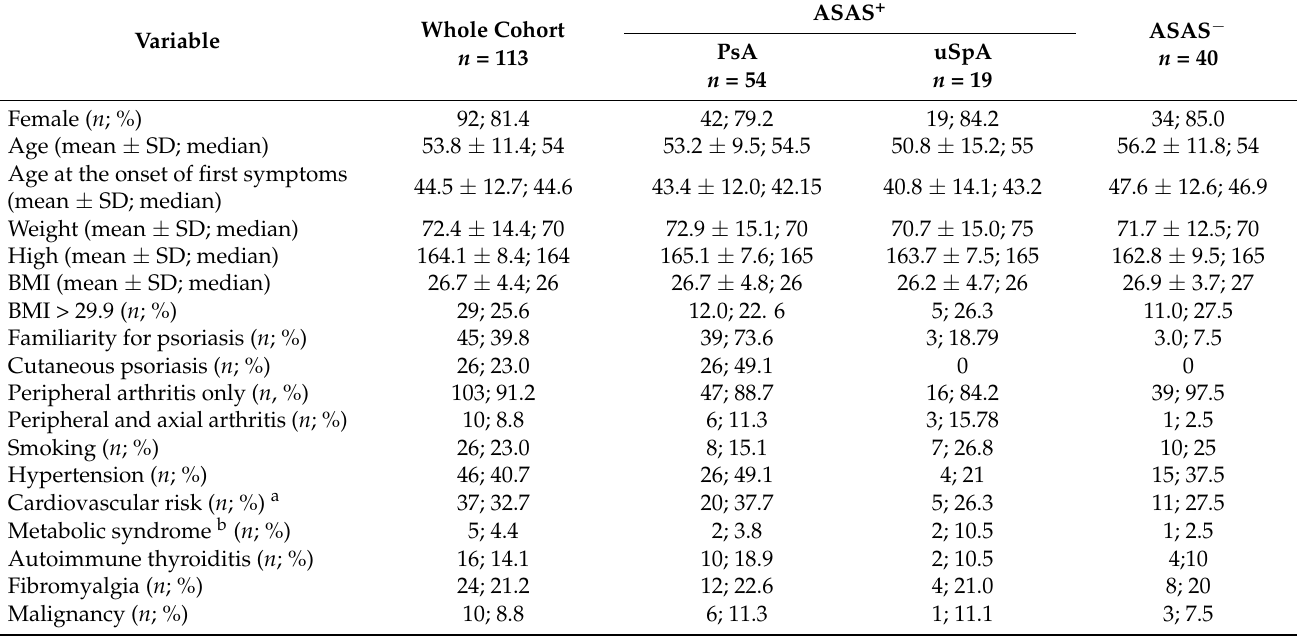
Table 1. Clinical characteristics of the 113 patients with peripheral seronegative enthesitis/arthritis (E/A), in the whole cohort, and the ASAS + and ASAS −